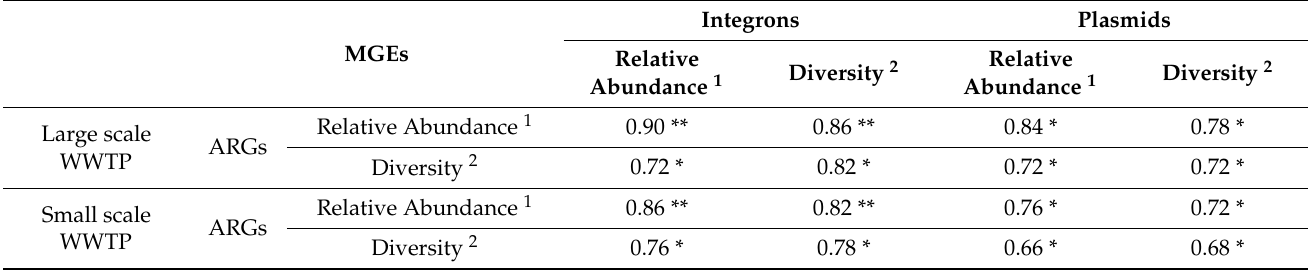
Integrons Plasmids Relative Relative Diversity 2 Diversity 2 Abundance 1 Abundance 1